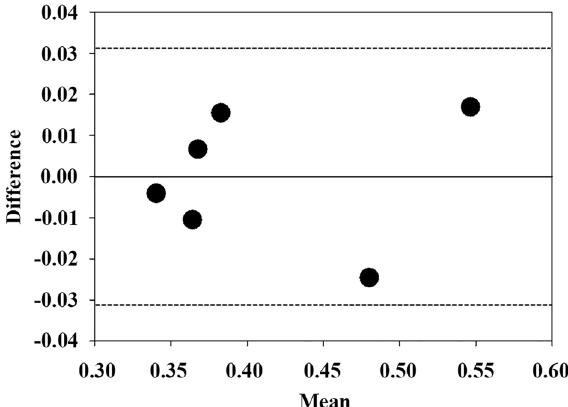
Figure 9. Bland–Altman plot demonstrating difference between the actual ESR values and predicted ESR values obtained by the GRU–PLSR model for periodontitis subjects. The horizontal axis represents the mean ESR values estimated by the two values, and the vertical axis shows the difference between them. The bold line and dashed lines denote the mean value of bias and 95% limits of agreement, respectively (n =